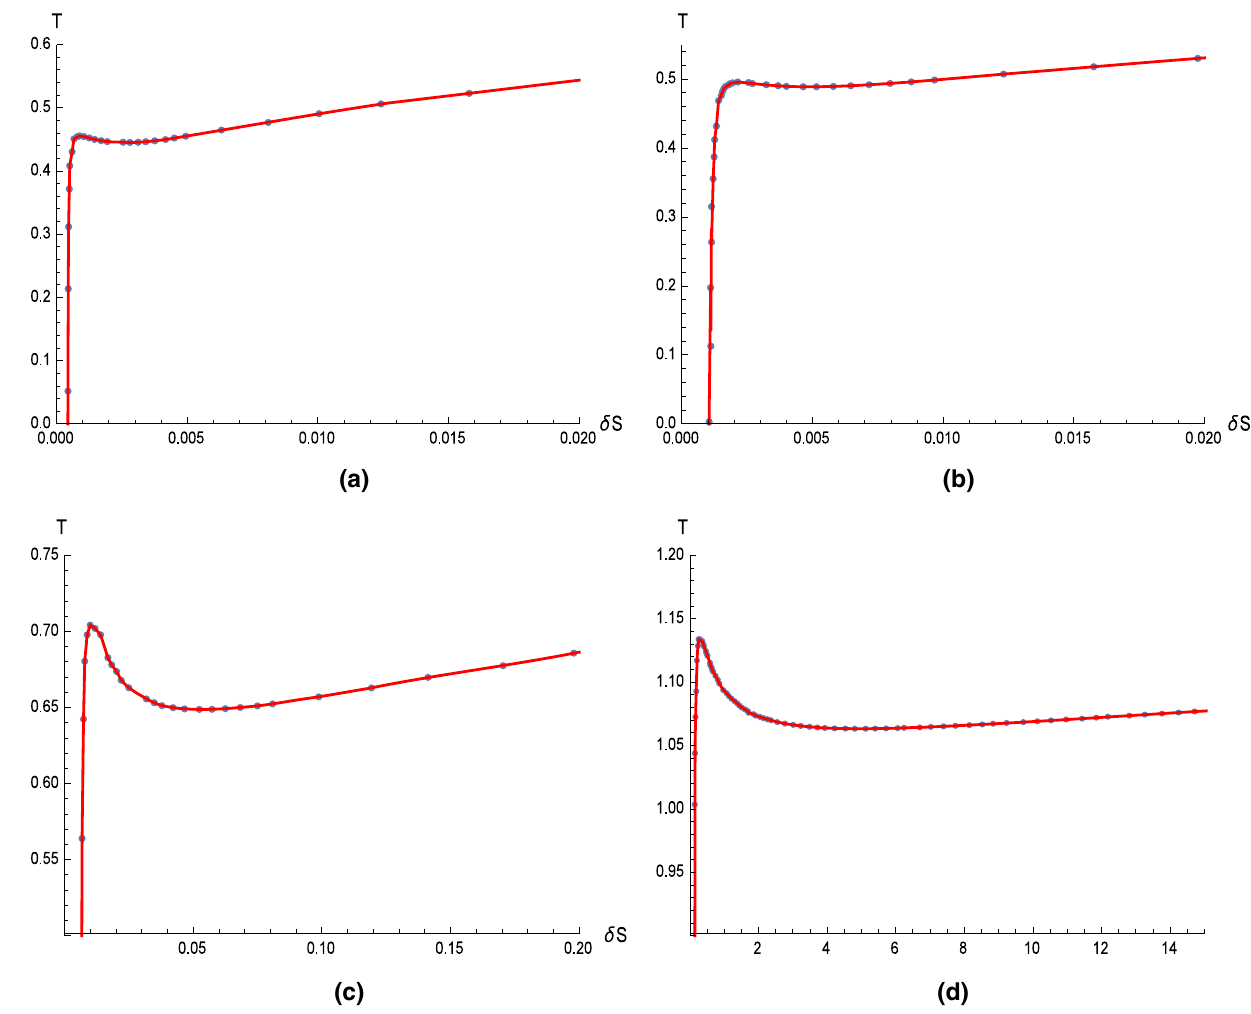
Fig. 8 T vs. δ S for n = 4 ,θ 0 = 0 . 2. a α = 0 , q = 0 . 12, b α = 0 . 25 , q = 0 . 12, c α = 0 . 5 , q = 0 . 06, d α = 0 . 75 , q = 0 .